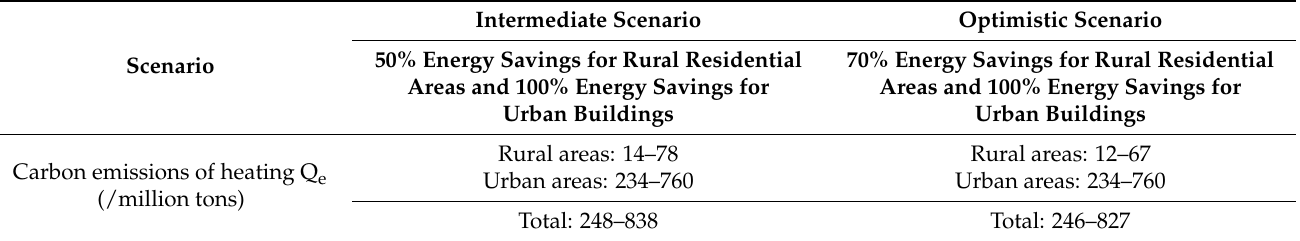
Table 6. Carbon emissions